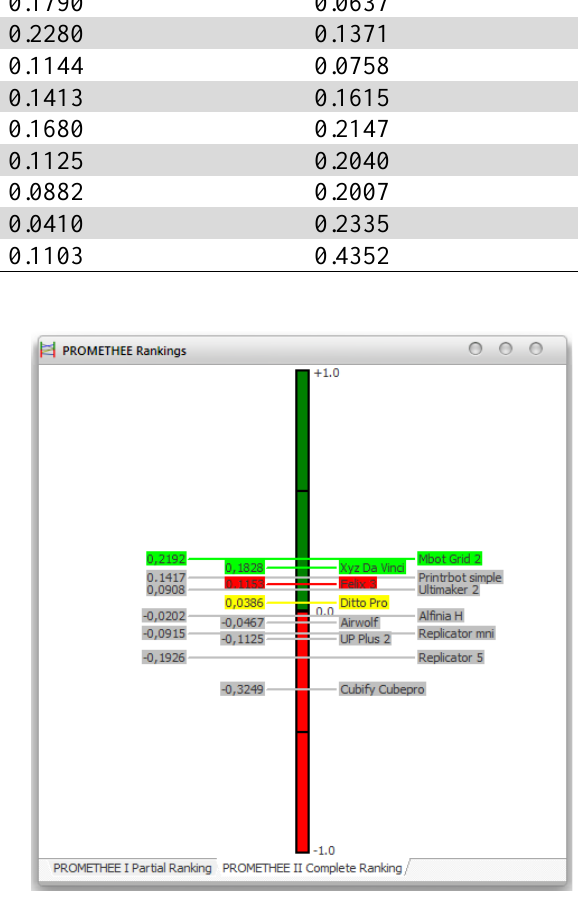
Fig. 3. GAIA Analysis Fig. 4. PROMETHEE II Complete